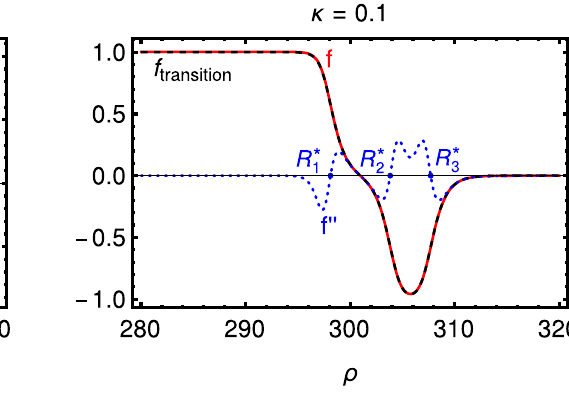
) = 0 (not the one at f = 0). The agreement between numer- by f (cid:12)(cid:12) ( R ∗ j ical and transition profile becomes better for small defined j